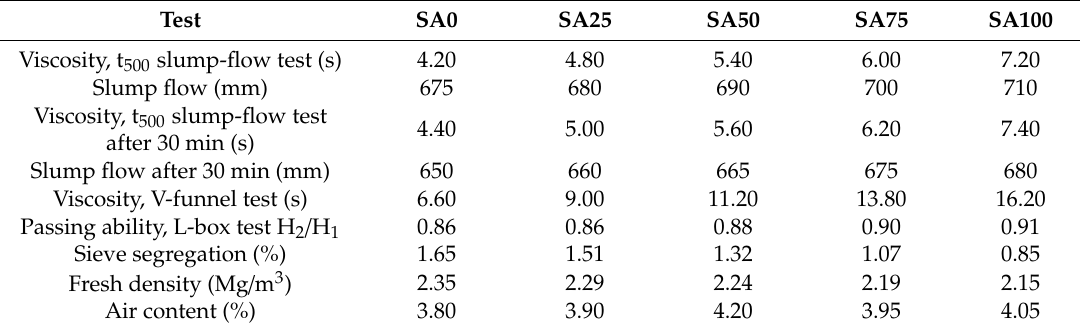
Table 5. Results of in-fresh state